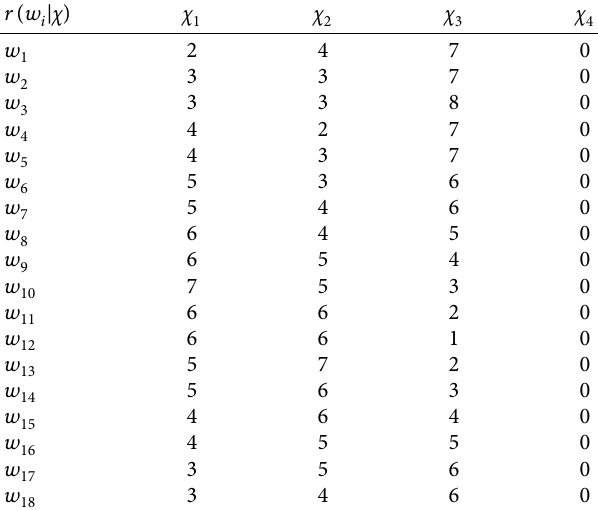
Table 1: Representations of the vertices when n � 13 w.r.t χ .